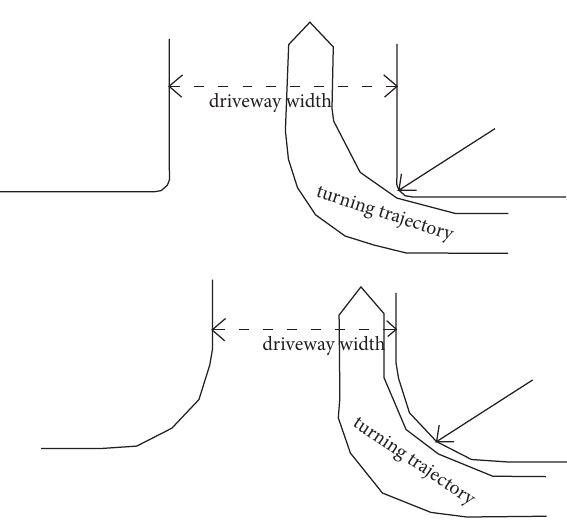
Figure 2: Turning trajectory of entry